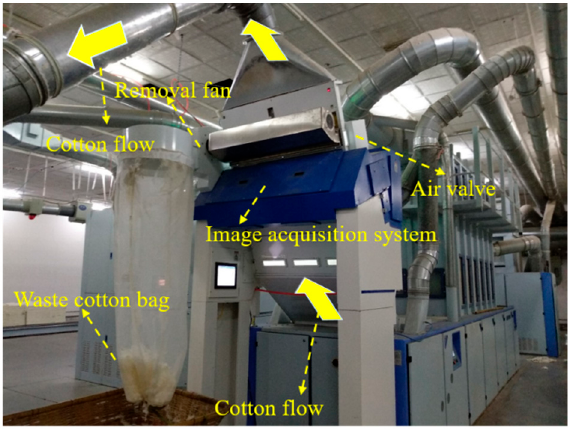
Figure 3. The structure design of a foreign fiber cleaning machine.